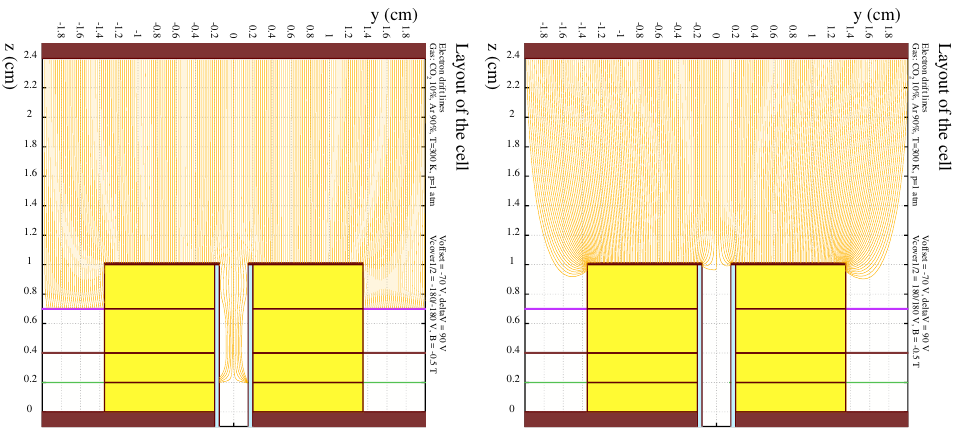
Figure 10. The electron drift lines, before ( left ) and after ( right ) the modification of the potential at the chamber boundaries of a TPC